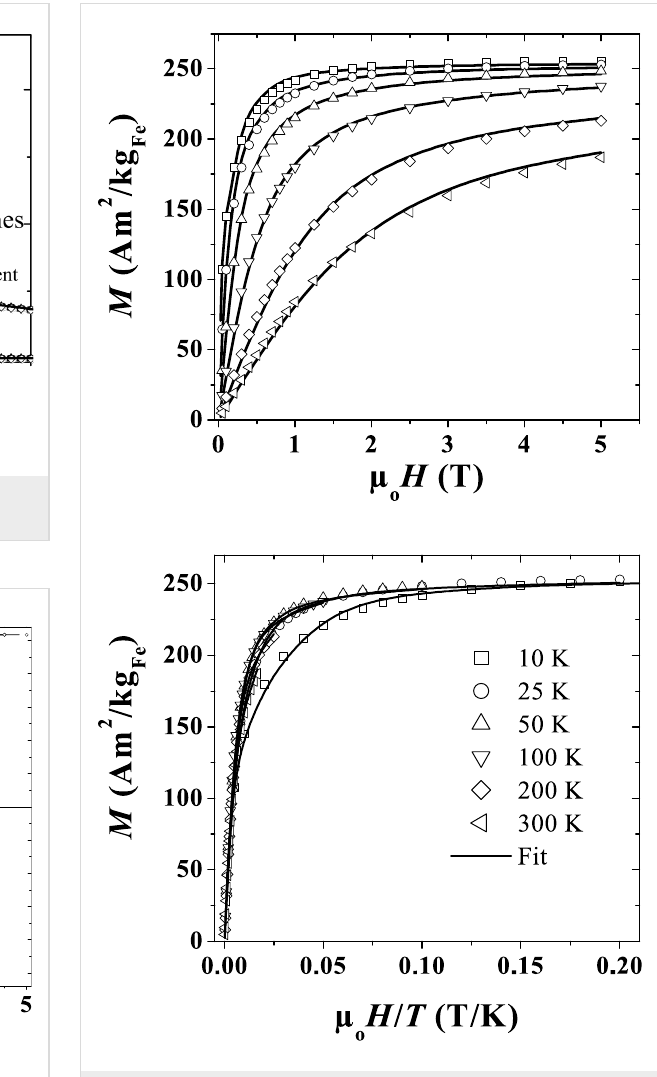
Figure 9: Magnetization curves in the superparamagnetic regime plotted versus the applied magnetic field (top) and versus the magnetic field divided by the temperature (bottom), for different